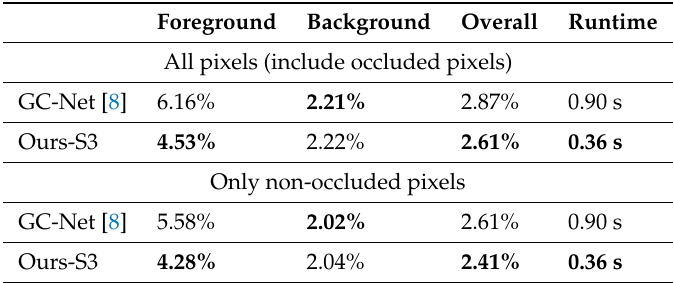
Table 4. Results on the KITTI 2015 stereo